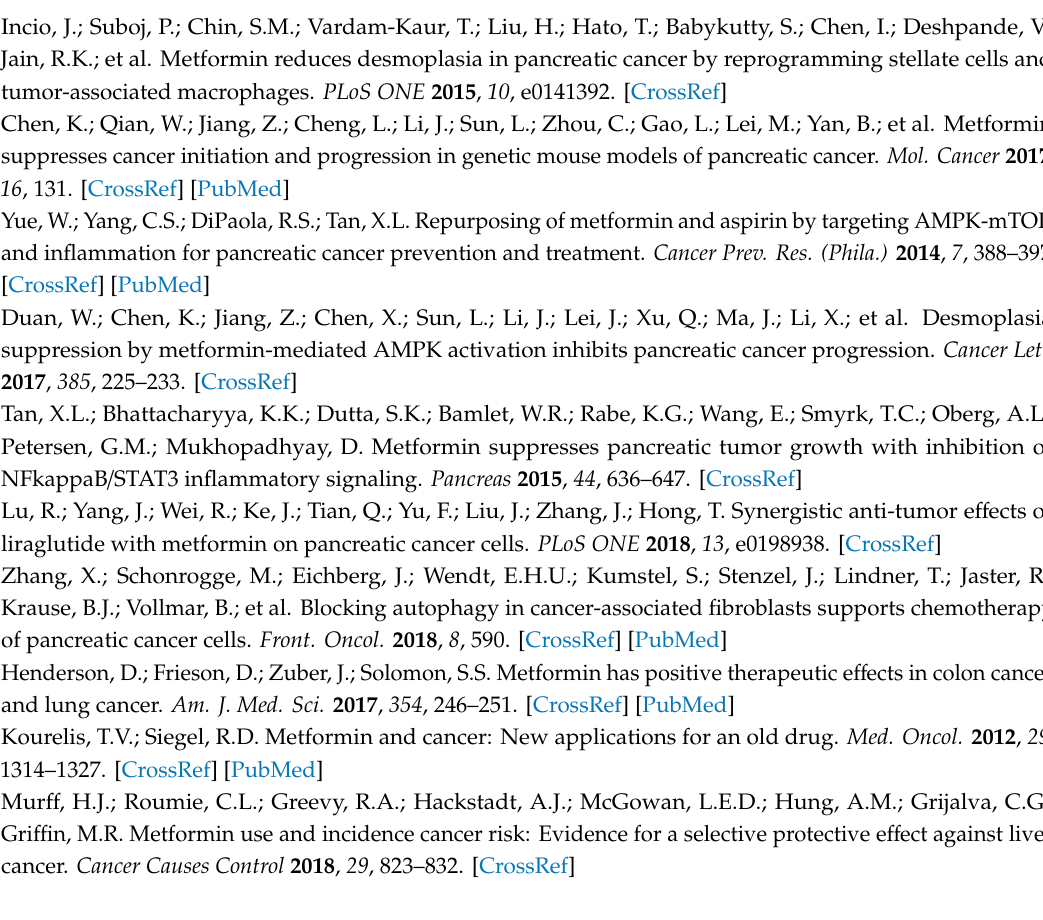
Table S1: Unadjusted analysis using Cox models with time-varying covariates, Table S2: Univariate analysis of recurrence-free survival, Table S3: Multivariate analysis of recurrence-free survival with covariates selected using the backward elimination method, Table S4: Univariate analysis of overall survival, Table S5: Multivariate analysis of overall survival with covariates selected using the backward elimination method, Table S6: Analysis of the interactive e ff ect of clinical stages on clinical outcomes considering the start date of metformin use, Table S7: Analysis of the interactive e ff ect of clinical stages on clinical outcomes considering both the start and stop dates of metformin use, Table S8: Subgroup analysis of the dose-dependent e ff ect of metformin, Figure S1: ( A ) Kaplan-Meier curves of recurrence-free survival after surgery in the metformin group and the other medication group. ( B ) Kaplan-Meier curves of overall survival after surgery in the metformin group and the other medication